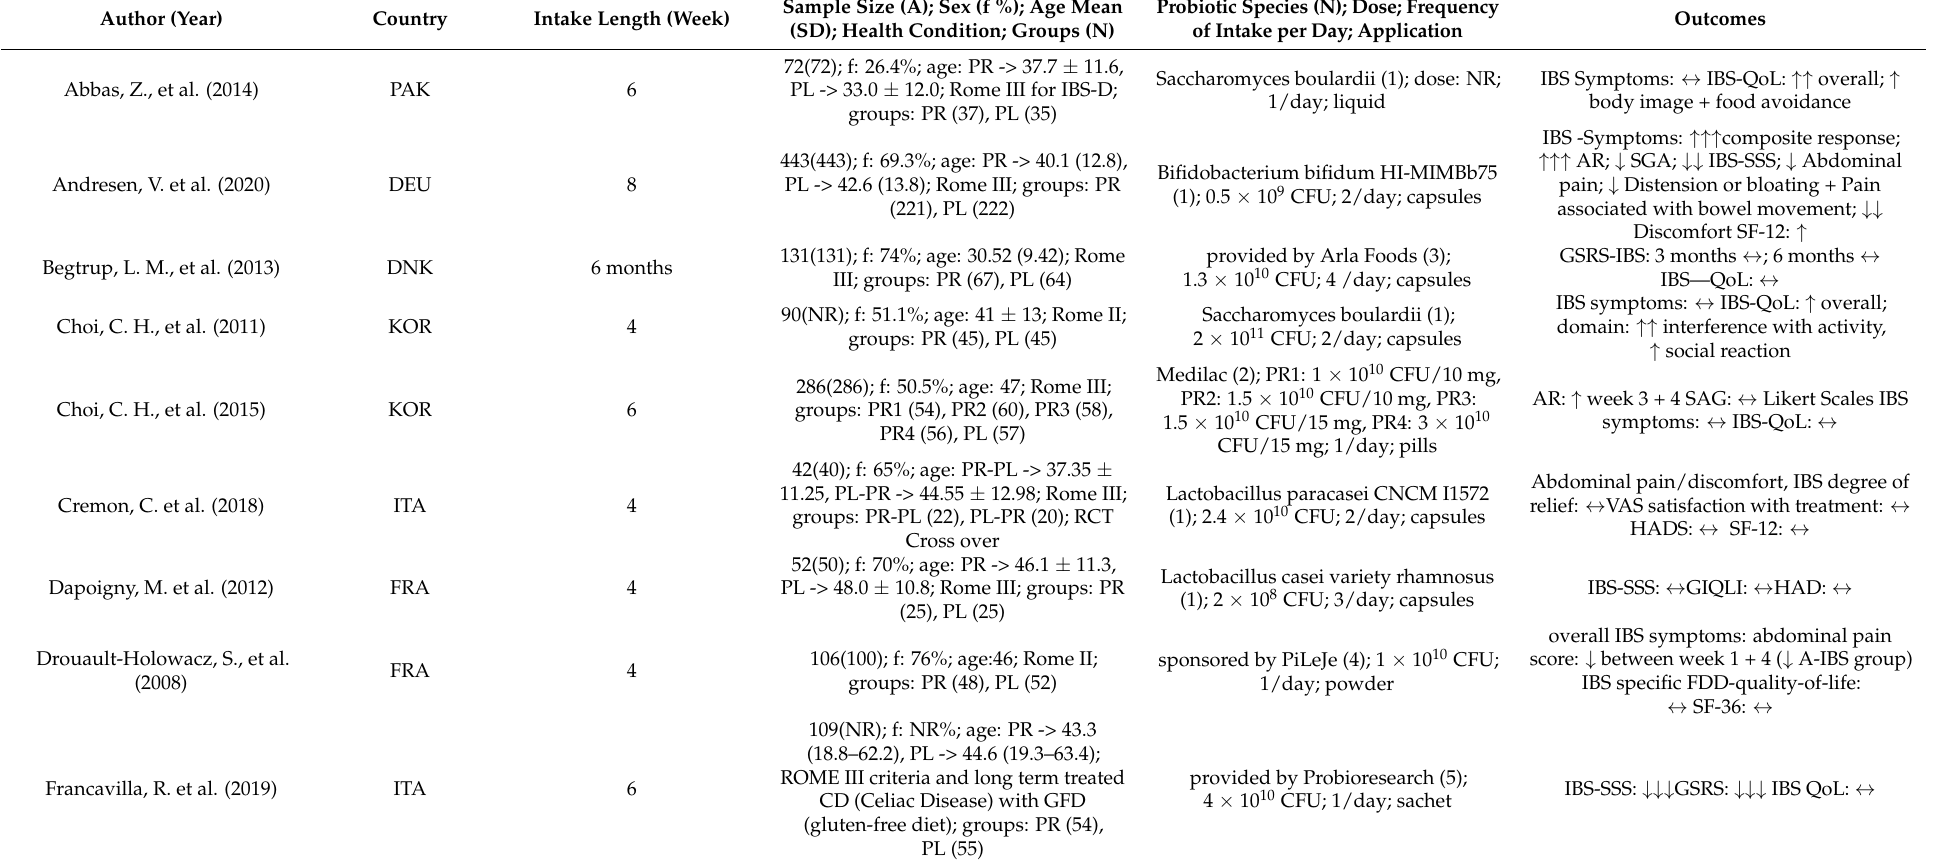
Table 1. Summarized Trial Characteristics. IBS symptom improvement in probiotic versus placebo group: ↑↑↑ = p < 0.001, ↑↑ = p < 0.01, ↑ = p < 0.05; Symptom deterioration in probiotic versus placebo group: ↓↓↓ = p < 0.001, ↓↓ = p < 0.01, ↓ = p < 0.05; ↔ : no group differences; NR: not reported; A: analyzed sample size; PR: probiotic group; PL: placebo group; CFU: colony forming unit; SD: standard deviation; f: female; IRN: Iran; NLD: Netherlands; ITA: Italy; DNK: Denmark; KOR: Korea; JPN: Japan; IRL: Ireland; FRA: France; SWE: Sweden; CAN: